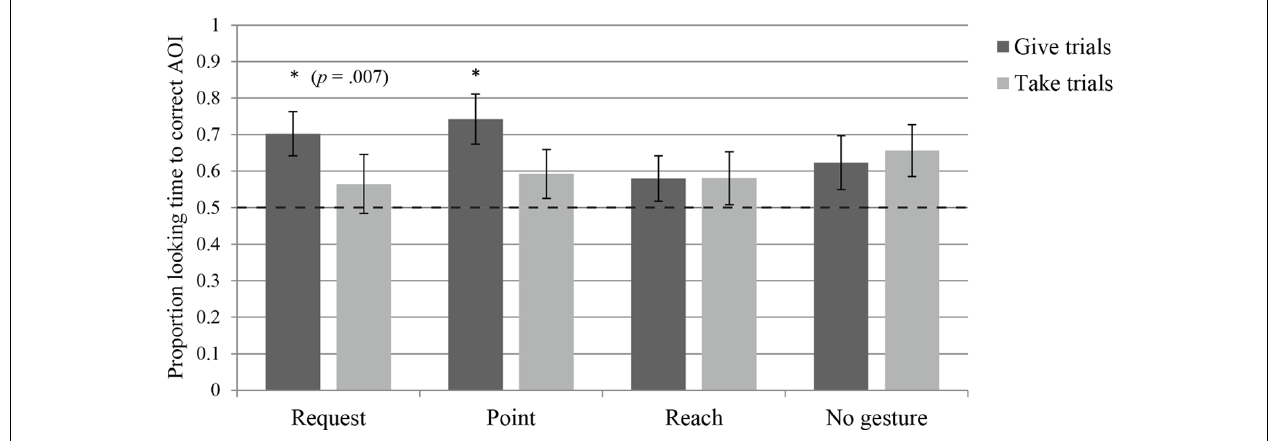
FIGURE 3 |Average proportion of looking time to the target bowlAOI during the anticipatory phase for each of the four groups, separated into give trials – where theAddressee gave the object to the Gesturer – and